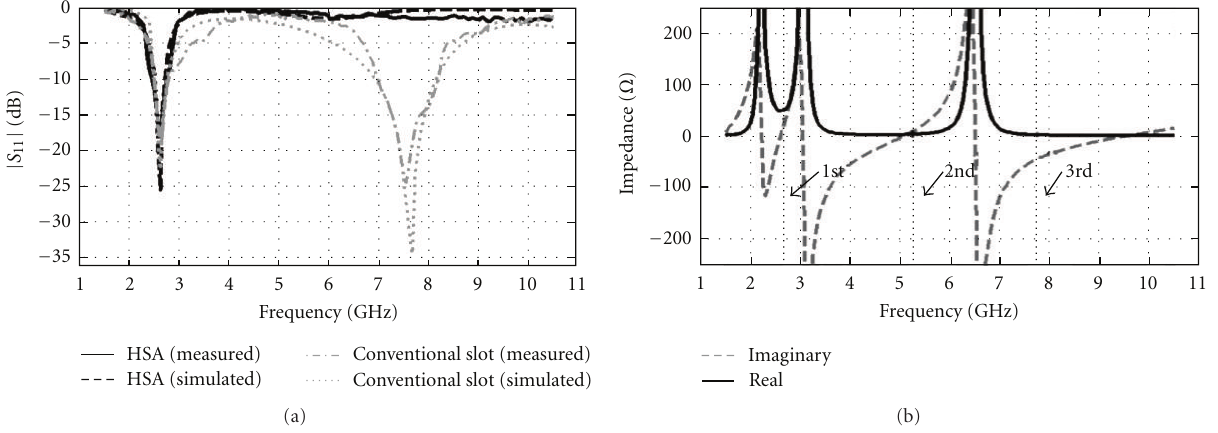
Figure 8: (a) Reflection coe ffi cients of the RDGS slot antenna and (b) measured input impedance of the RDGS slot antenna.